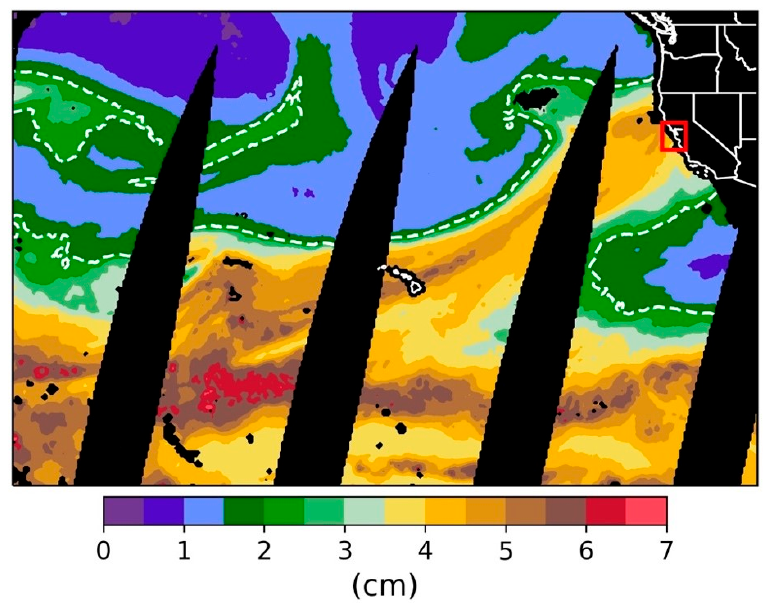
Figure 6. SSM/I satellite image of daily average column integrated water vapor for 6 April 2018. Red box is the approximate model domain. Dashed white line = 2 cm.